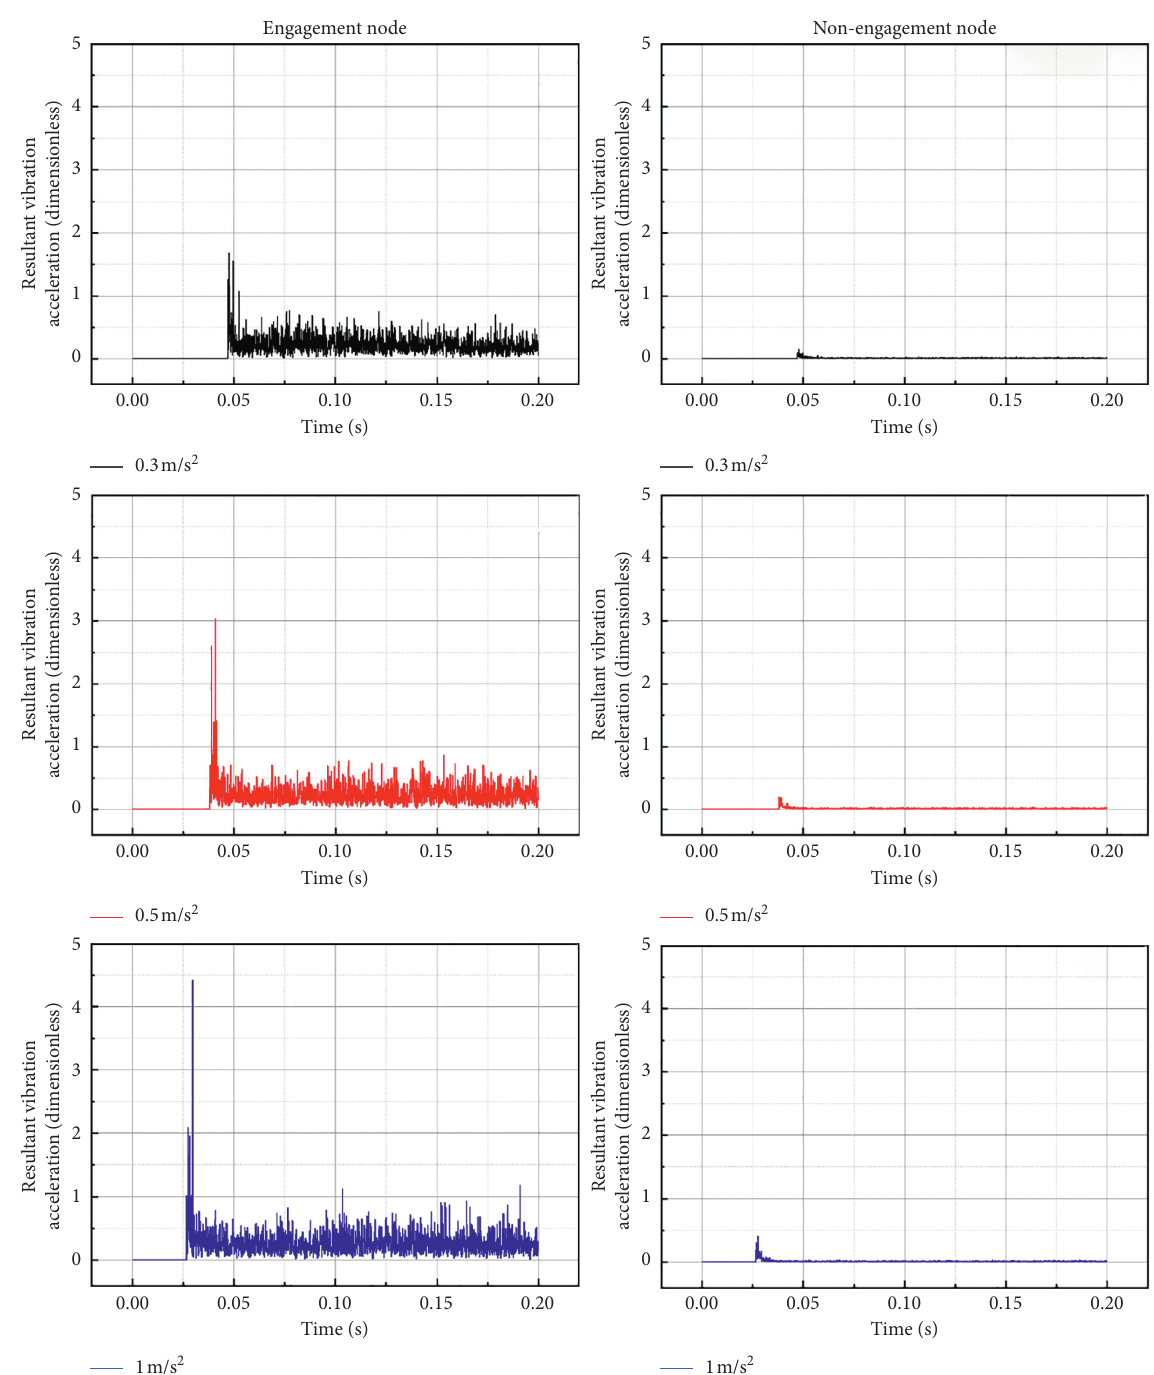
Figure 11: The comparison of resultant acceleration of two categories nodes on axle spline under three loading meshing force is divided into three phases. The first phase corresponding maximum meshing forces are 5.23 kN, is empty travel of axle spline, during which the wheel 4.03 kN, and 2.89 kN, respectively. The third phase shows spline remains static state until the instant before contact. that meshing force gradually decline to a constant value, about 300N ∼ 320N, which shows the case of spline cou- pling has reached a relatively stable stage. This result also relation between instantaneous meshing force and implies that as long as the engagement velocity in final engagement velocity. For instance, when the driving ac- stage remains the same, the meshing force will fluctuate celerations are 1 m/s 2 , 0.5 m/s 2 , and 0.3 m/s 2 , the within a roughly same range.